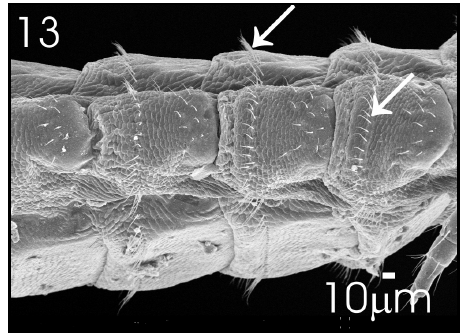
Fig. 13. Lateral view of the abdomen showing single transverse rows of short setae (arrows) situated on the dorsal and ventral surfaces of each segment.